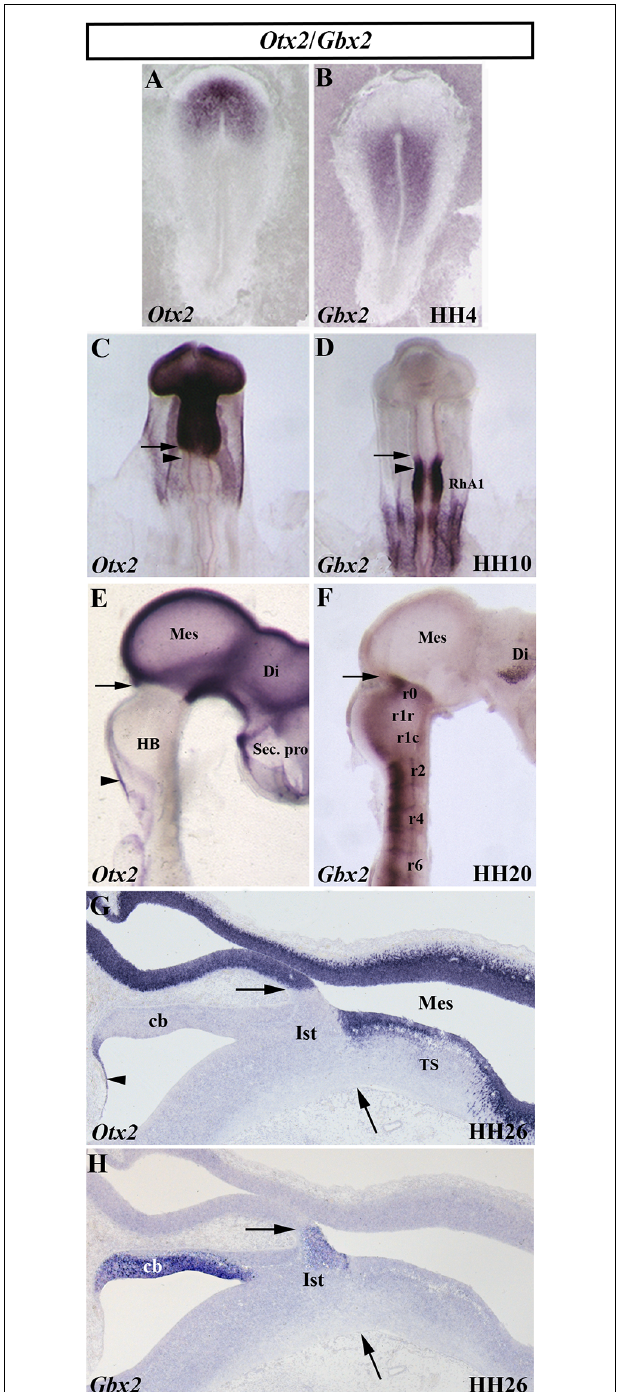
FIGURE 3 | Spatial and temporal distribution of Otx2 and Gbx2 transcripts in the chick developing midbrain-hindbrain (MH) domain at different developmental stages. Single in situ hybridization performed in whole-mount (A–F) and in sagittal sections (G,H) . Note that, at all analyzed stages, the Otx2 - and Gbx2 -expressing domains are contiguous and complementary: stage HH4 (A,B) , HH10 (C,D) , HH20 (E,F) , and HH26 (G,H) . The arrows point to the MH boundary (C–H) , whereas the arrowheads in (C) and (D)